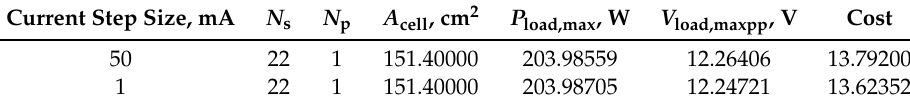
Table 23. Best solution (stack design) of [43].